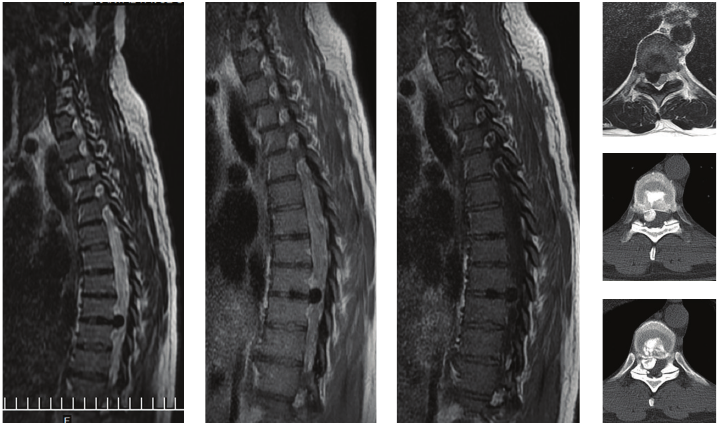
Figure 3: 36-year-old female. Weakness in lower extremities. Preoperative ASIA was C (Case 5). Preoperative CT and MRI revealed a thoracic 8-9 disc